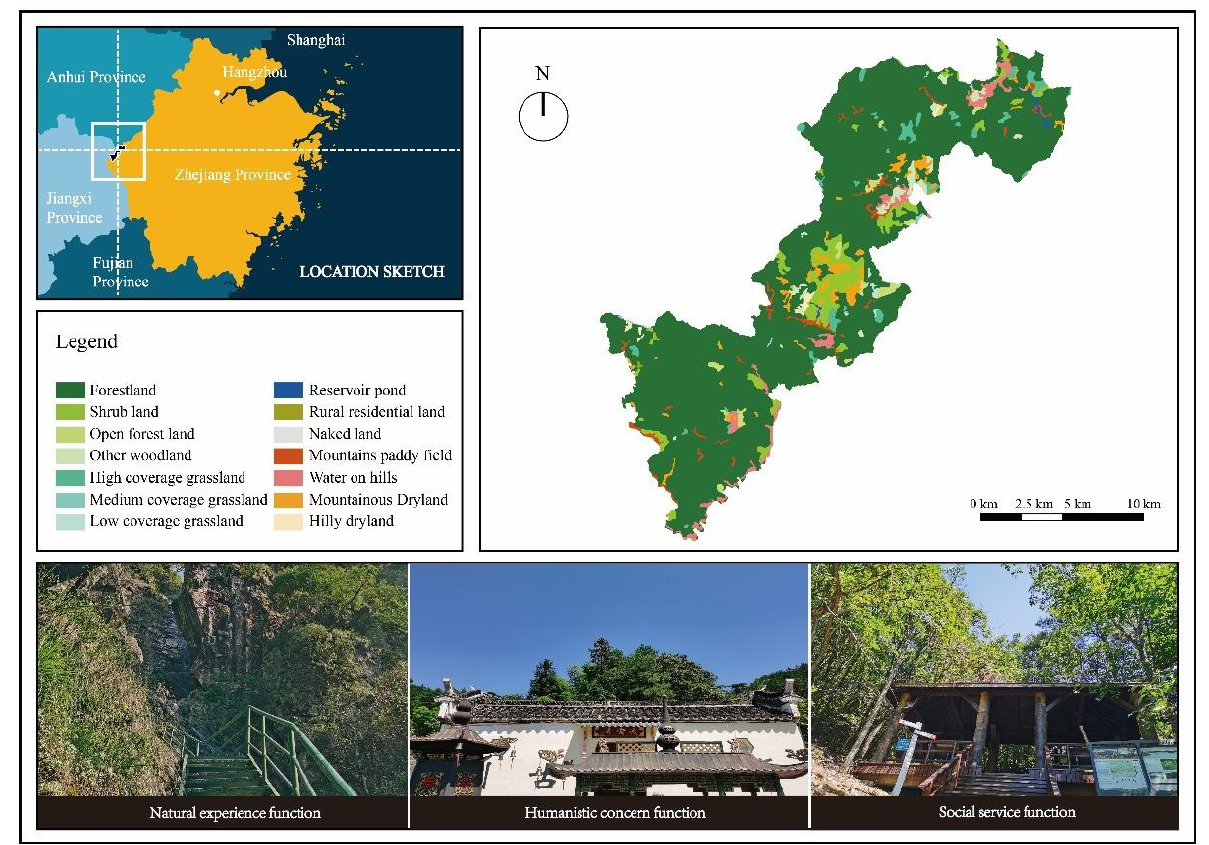
Figure 1. Land use map and cultural ecosystem service functions of the study area. Note: land use data are from the Resources and Environmental Science and Data Center, Chinese Academy of Sciences (https://www.resdc.cn/, accessed on 3 July 2022).